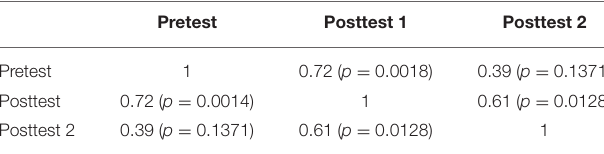
TABLE 3 | Correlations (Spearman coefficients) between the 3 stages in Experiment